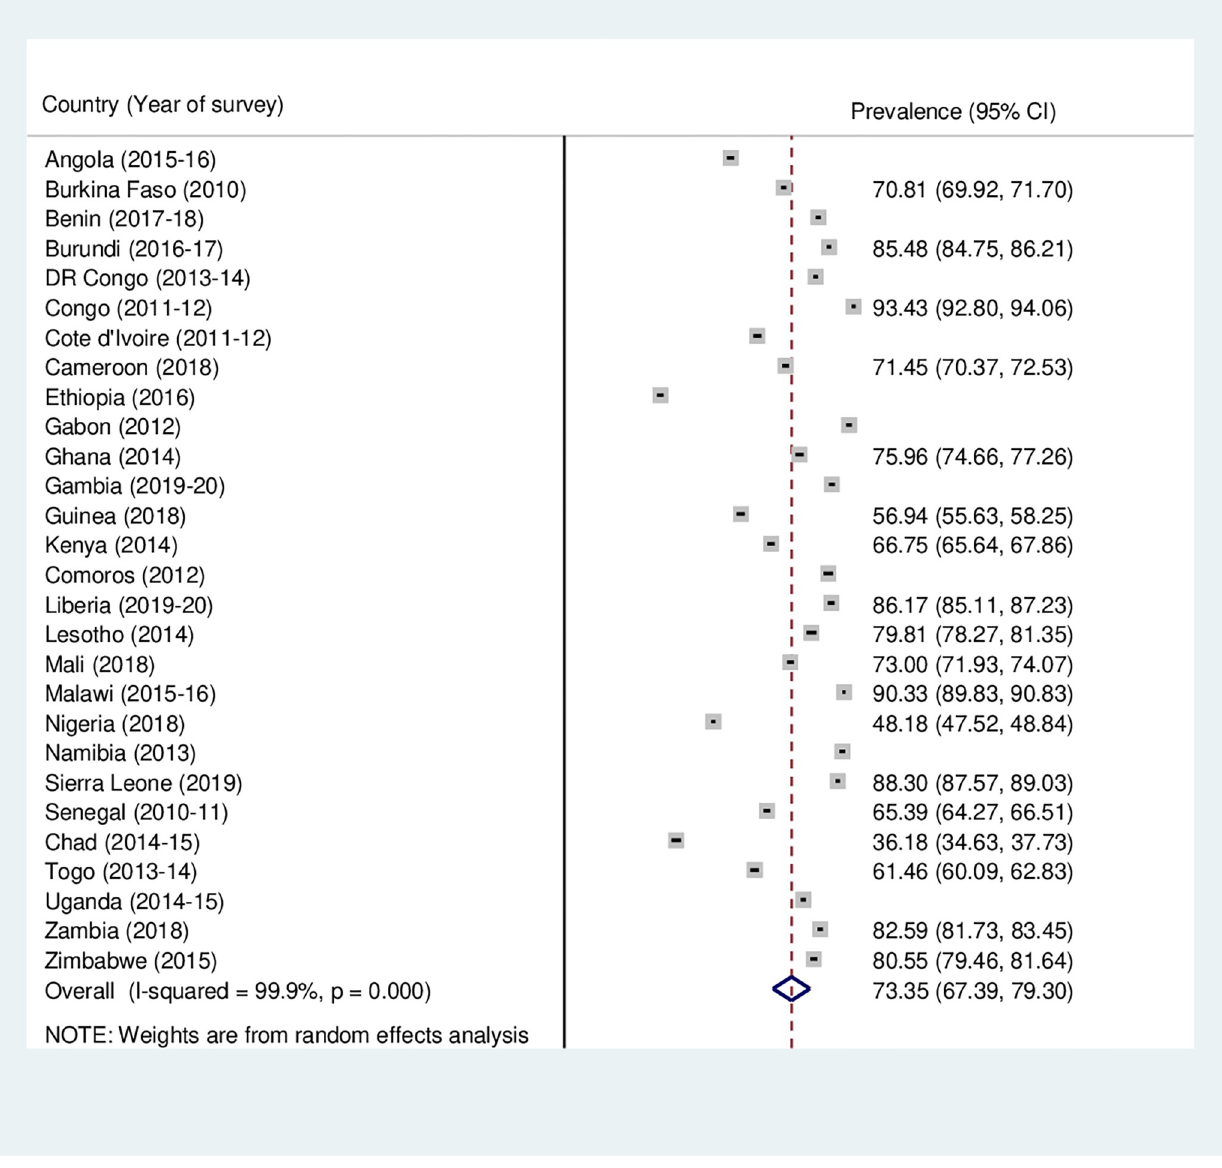
Fig 2. Forest plot showing the prevalence of skilled birth attendance during delivery among women in sub-Saharan Africa. determine the influence of different types of mass media variables on ANC, SBA, and PNC, a multilevel logistic regression was adopted and modelled in three steps. Model 0, I, and II were fitted to include the outcome variable, key explanatory variables only, and key explanatory var- iables and covariates from the best selection method respectively. The rest of the AIC was used to test for the model fitness and comparison. Adjusted odds ratio (aOR) with their 95% confi- dence intervals (CIs) were used to present the results of the regression analysis in a tabular form. Furthermore, the intraclass correlation coefficient, and the variance component is reported. The women’s sample weight (v005/1,000,000) was applied in all analyses to alleviate biased estimates based on the DHS guidelines. Also, we used the survey set ‘svy’ command in